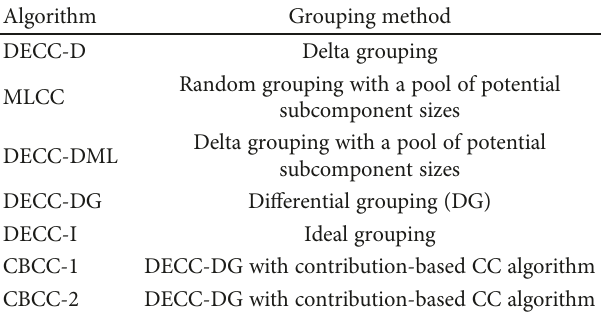
Table 2: Description of compared